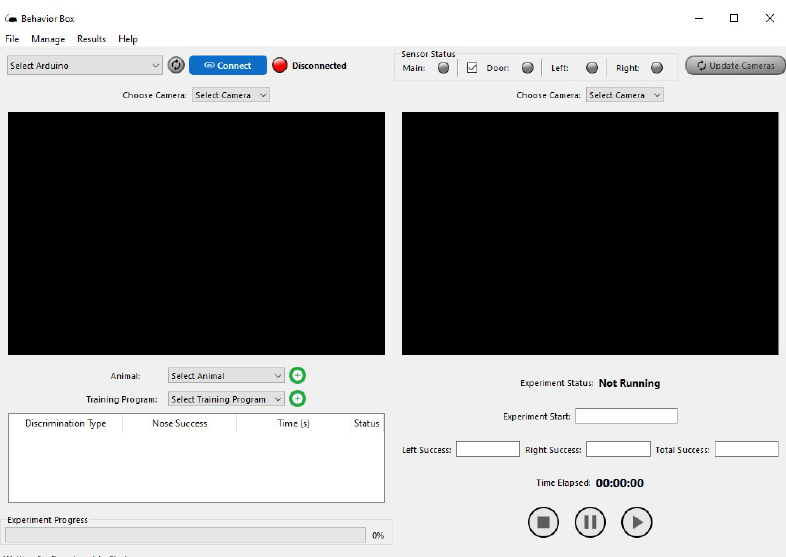
Figure 6. Software: behavioral box supervisory